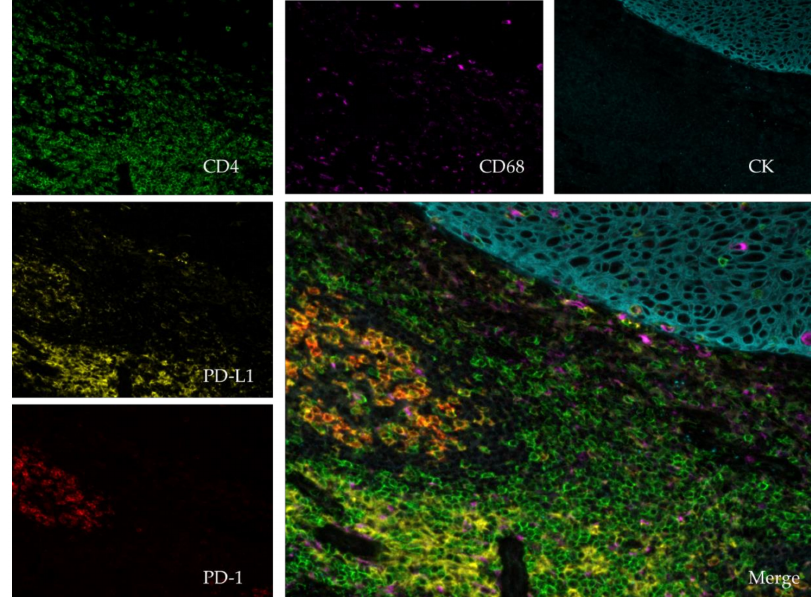
Figure 2. Immunofluorescent multiplexing, image scanned with a spectral scanner (Polaris ® ; PerkinElmer, Waltham, MA, USA) using 20 × magnification. The tissue is a paraffin embedded tonsil. The stains are as follows: pan-Cytokeratin (CK, teal), CD4 (green), CD68 (purple), PD-1 (red), PD-L1 (yellow) and dapi (blue). The central picture compiles the entire staining